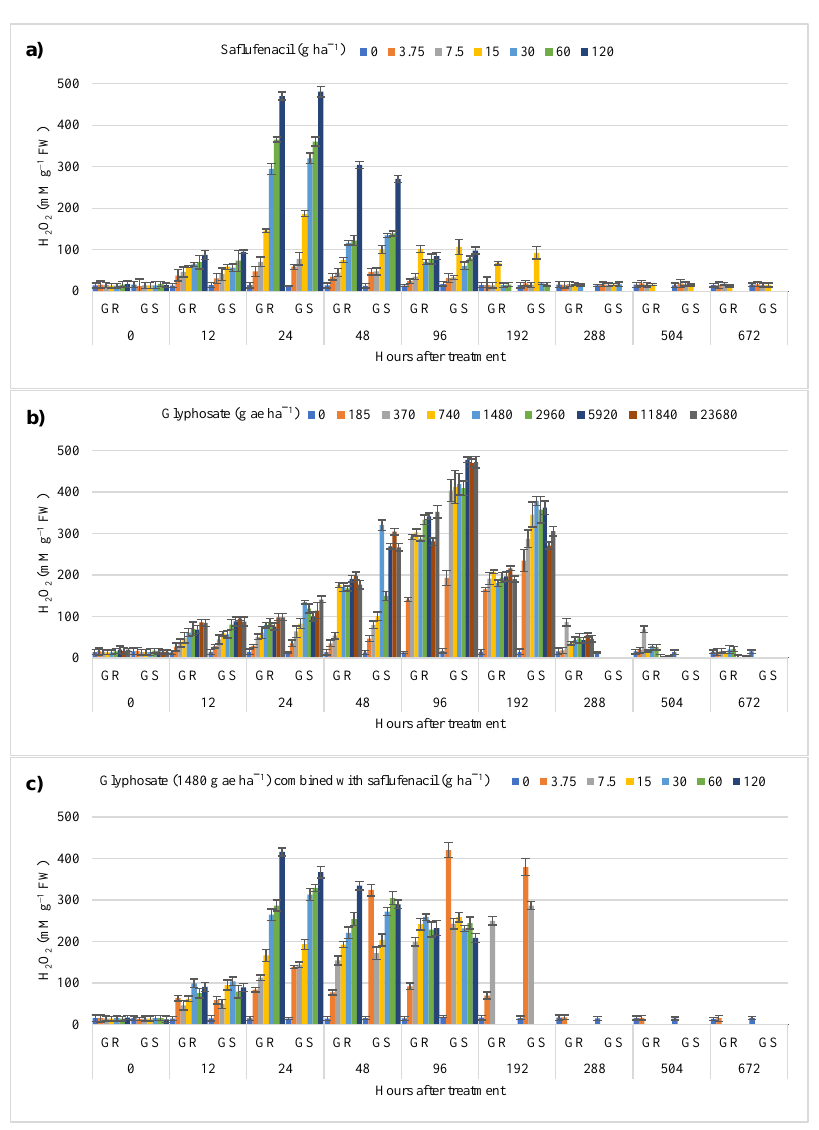
Figure 4. Time-course results of oxidative stress (H 2 O 2 ) in glyphosate-resistant (GR) and -sensitive (GS) biotypes of Conyza bonariensis in response to treatment with (a) saflufenacil (untreated, 3.75, 7.5, 15, 30, 60, and 120 g ha −1 ), (b) glyphosate (0, 185, 370, 740, 1480, 2960, 5920, 11,840, and 23,680 g ae ha −1 ), and (c) glyphosate (1480 g ae ha −1 ) combined with saflufenacil rates (untreated, 3.75, 7.5, 15, 30, 60, and 120 g ha −1 ). The interval bars represent 95% confidence intervals (CI). Individual comparisons between biotypes for each respective herbicide rate and time after treatments are presented in Tables S1–S3. Regressions are presented in Tables S4–S6.